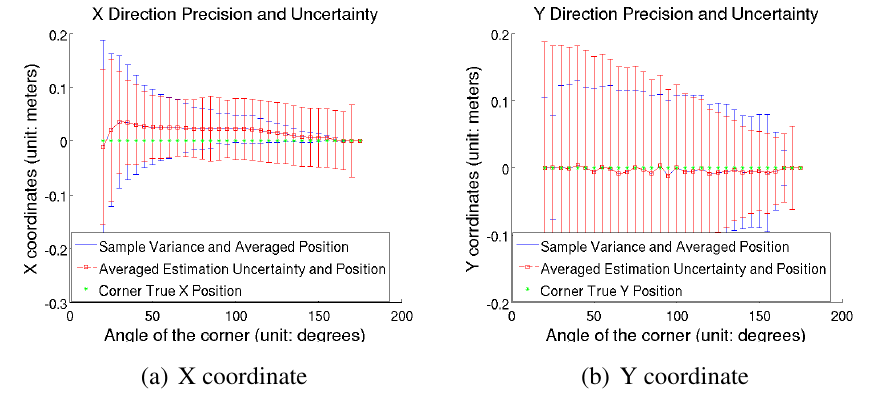
Figure 8. Feature precision. The x direction and the y direction precisions were demonstrated in (a) and (b), respectively. Blue solid lines, red dash lines and green star marks indicate sample variances, estimated variances and true corner positions,